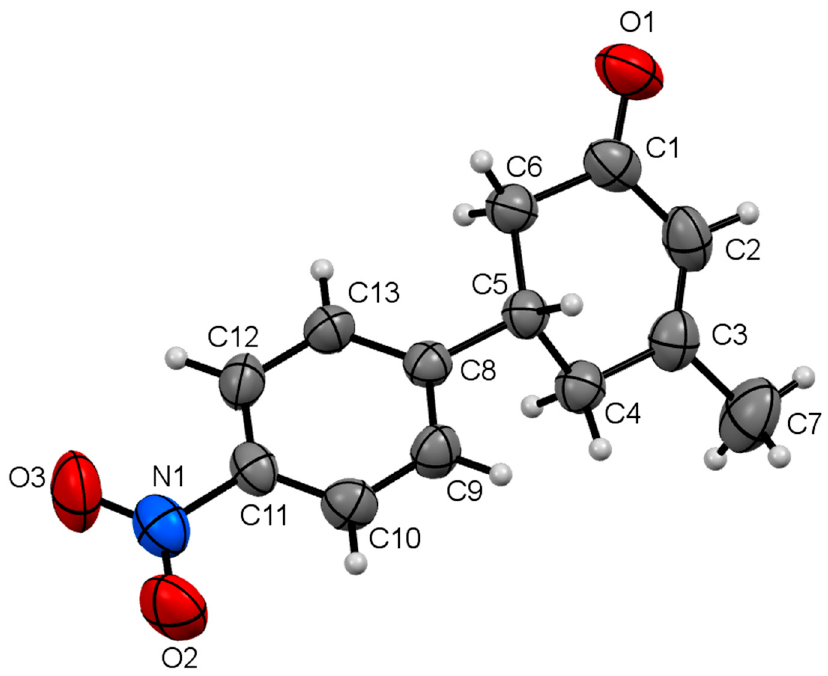
Figure 4. The ORTEP drawing of compound IV showing displacement ellipsoids drawn at the 50% probability level.